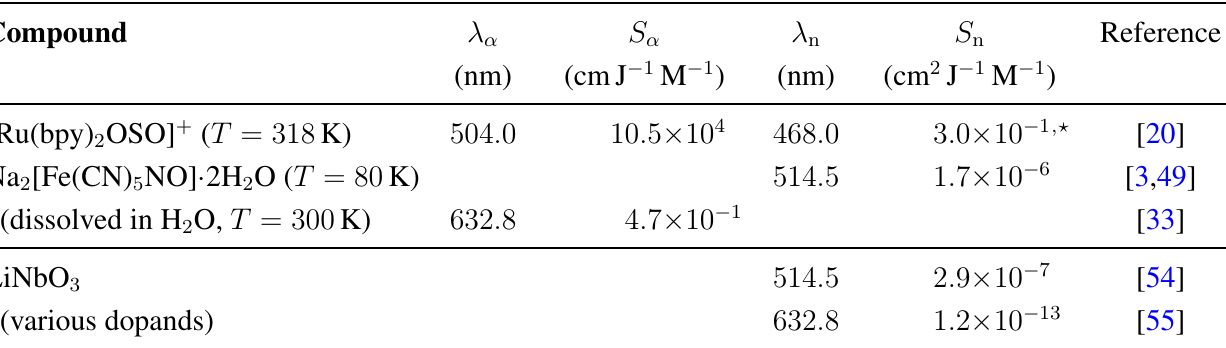
Table 2. Photochromic S and photorefractive sensitivities S α wavelength λ , λ . Values marked with a star ( (cid:63) ) are estimated via Kramers–Kronig relation. α n For comparison sensitivities for photorefractive lithium niobate are